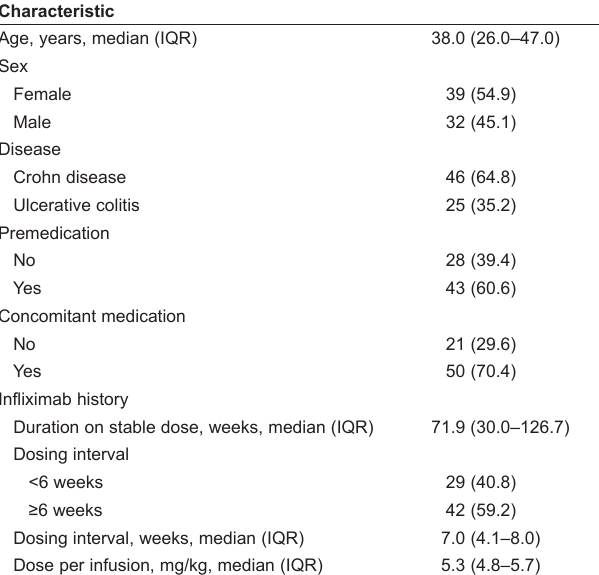
TABle 1 Demographics of inflammatory bowel disease outpatients receiving stable maintenance infliximab therapy at the Infliximab Infusion Clinic, University of Alberta, edmonton,